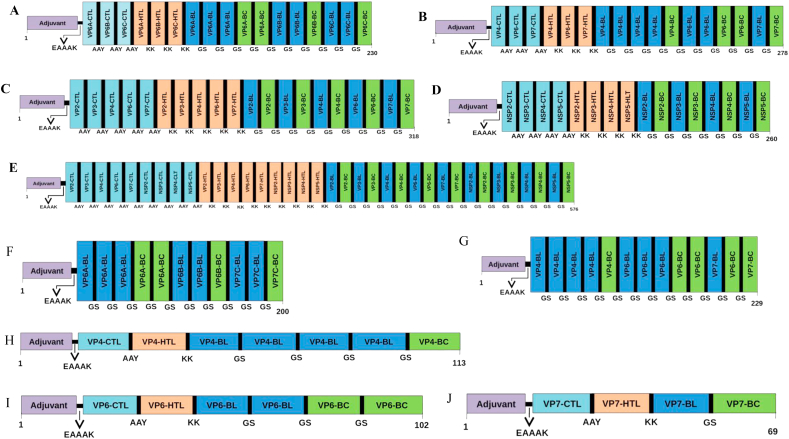
Schematic diagram of multi-epitope chimeric constructs. The multi-epitope constructs sequence consisting adjuvant followed by T- and B-cell epitope. Adjuvant and CTL epitope has been joined by EAAAK linker, whereas the AAY, KK and GGGGS linkers were used to join the CTL, HTL and linear/conformational B-cell epitopes, respectively. A. Construct 1 (VP6A/B/C), B. Construct 2 (VP6/4/7), C. Construct 3 (VP2/3/4/6/7), D. Construct 4 (NSP2/3/4/5) and E. Construct 5 (VP2/3/4/6/7-NSP2/3/4/5), F. Construct 6 (VP6A/B/C–B), G. Construct 7 (VP4/6/7-B), H. Construct 8 (VP4/A), I. Construct 9 (VP6/A) and J. Construct 10 (VP7/A); (BL- Linear B-cell epitope, BC- Conformational B-cell epitope). A/B/C: VP6 sequence of group A, B and C rotaviruses; A: group A rotavirus; B: B-cell epitopes (Both linear and conformational).